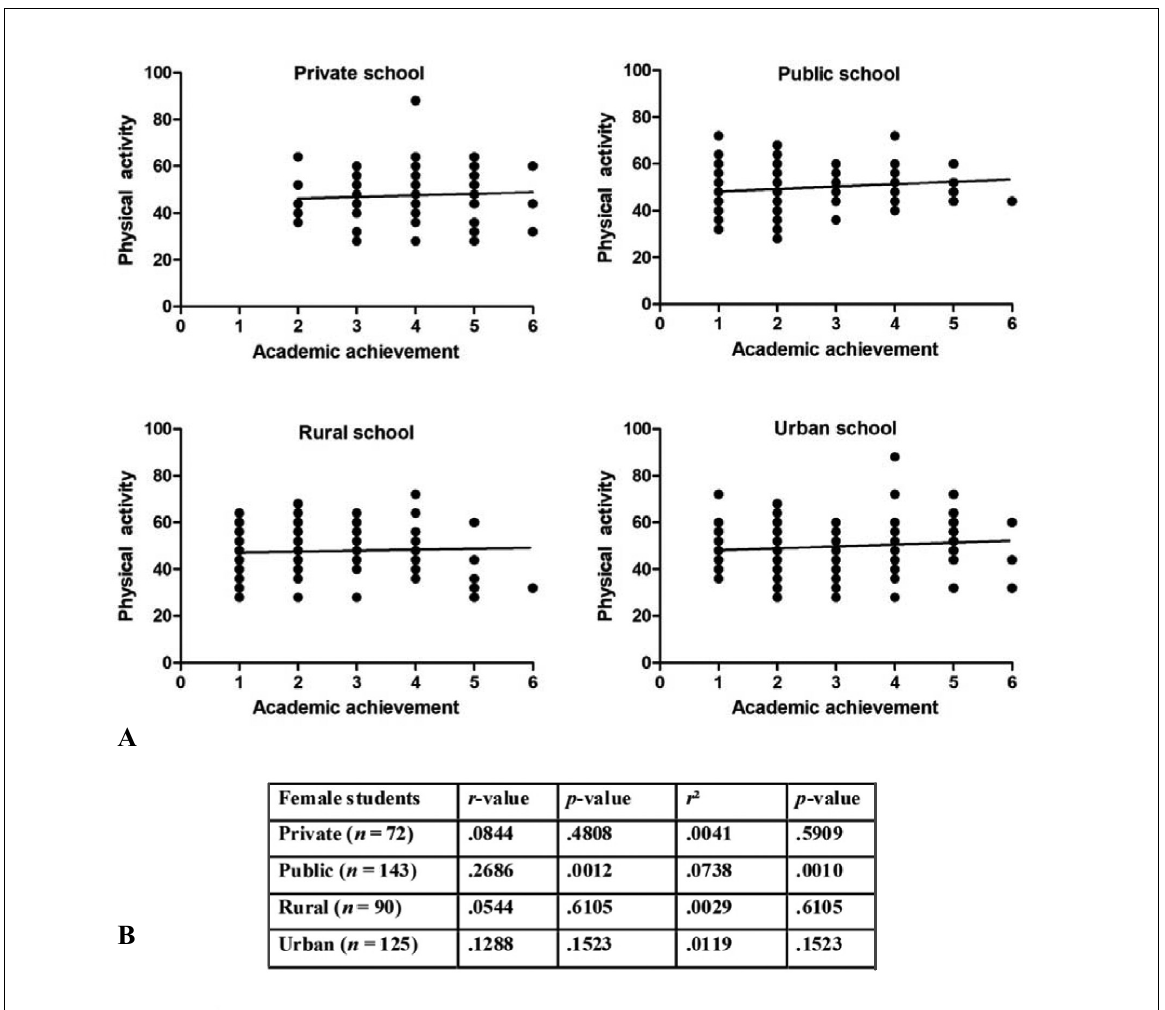
Figure 4. A-Correlation between physical activity (PA) and academic performance (AP) of female students in private, public, rural and urban Schools. B-corresponding table illustration spearman correlation coefficient ( r ) and goodness of fit ( r 2 ) Note. n – number of